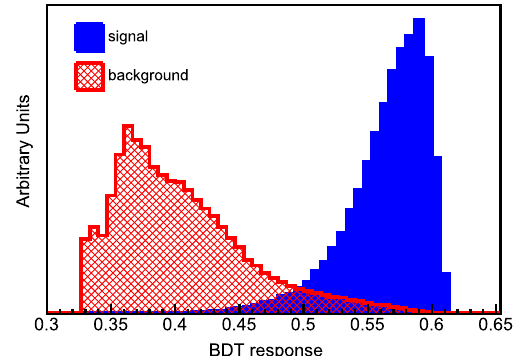
Fig. 35 BoostedDecisionTreeresponsefor n − ¯ n oscillationforsignal (blue) and background (red)